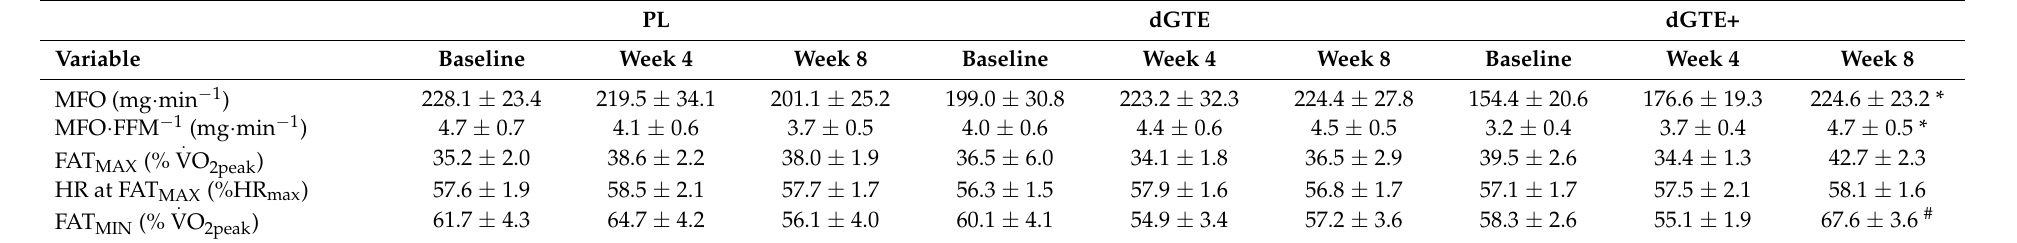
Table 4. Mean fat oxidation measures at baseline (week 0), week 4 and 8 between intervention groups.